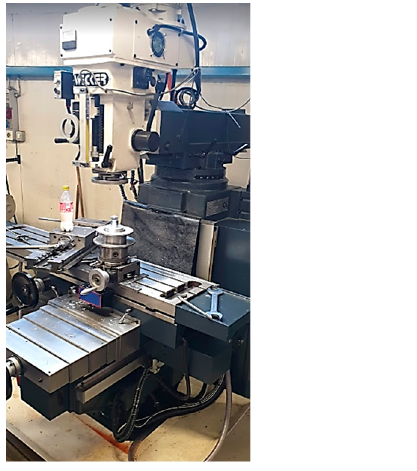
Figure 11. Fixing the part on the milling machine table.